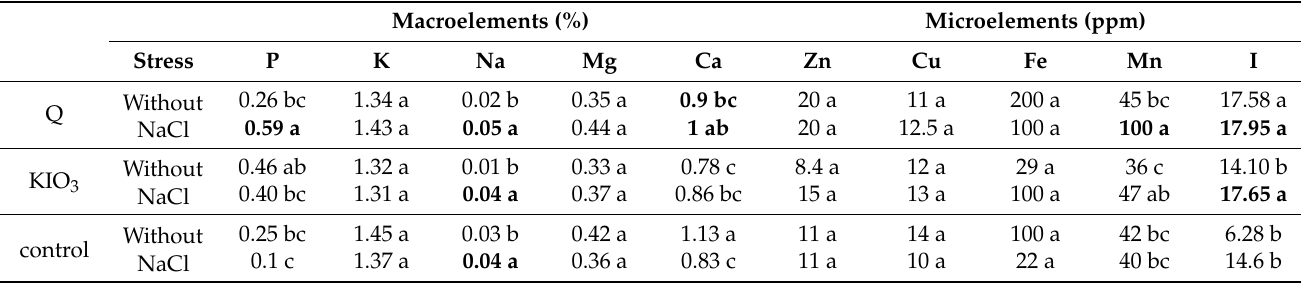
Table 7. Effect of iodine-based products on minerals content in leaves, with and without salt stress. Macroelements (%)